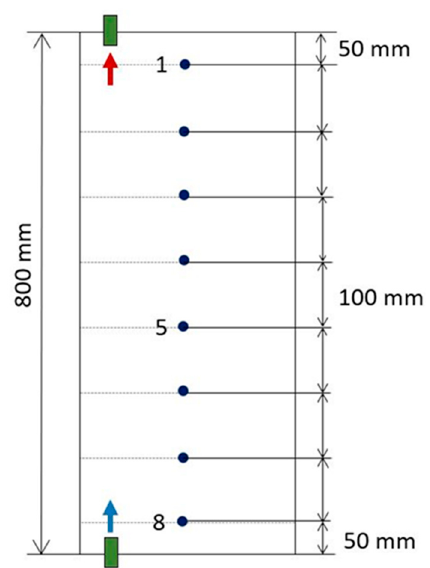
Figure 15. Schematic representation of the experimental tank for the discharge phase [10]. The cold-water inlet (blue arrow) and the hot water outlet (red arrow) are placed at the bottom and the top of the tank, respectively. Table 3. Measurement devices used for the discharge experimental trial. Quantity